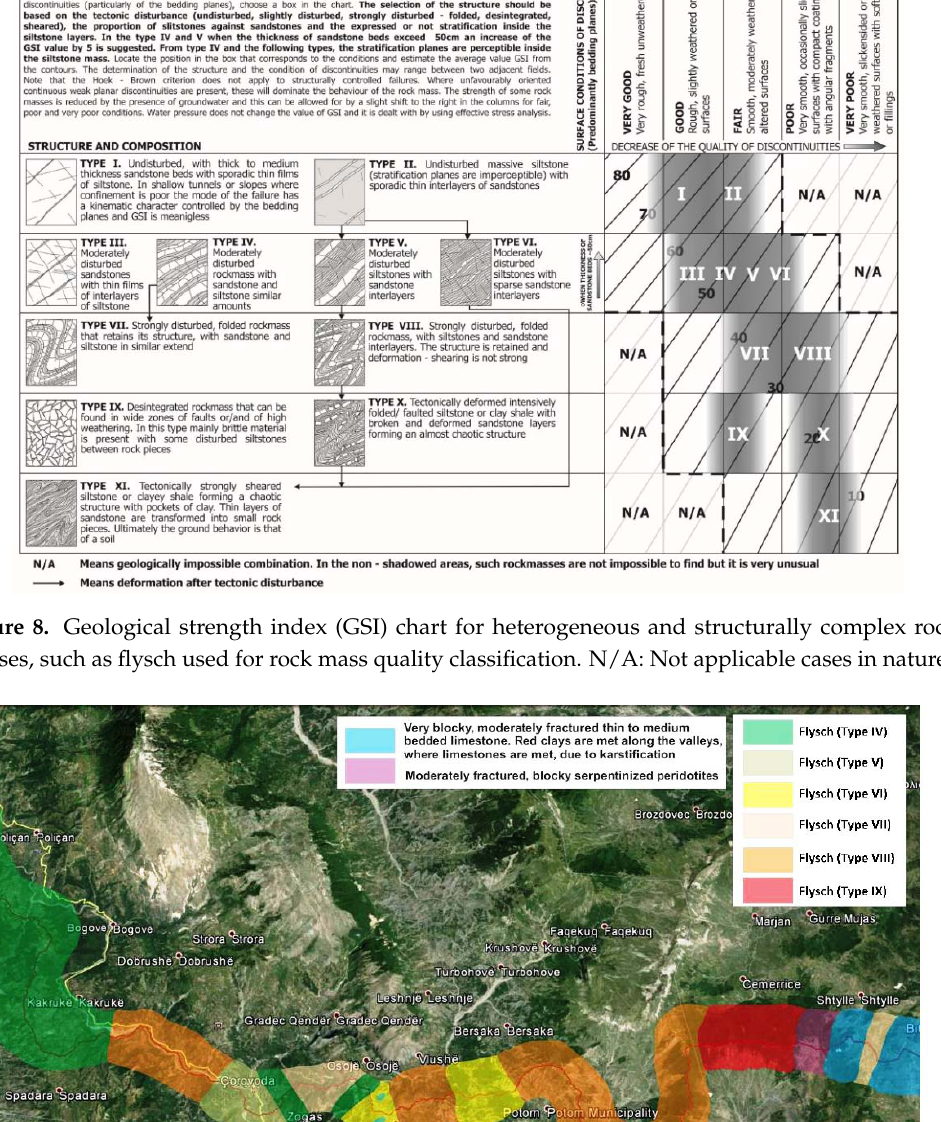
Figure 9. Zonation of the rock mass types and quality along the examined TAP route using the GSI (Figure 8) system for tectonically disturbed heterogeneous rock masses. The areas where most new identified landslides were encountered are characterised by the presence of flysch types VIII (i.e., strongly disturbed siltstones, folded rock mass, with sandstone interlayers) and IX (i.e., tectonically deformed, intensively folded/faulted siltstone with broken and deformed sandstone layers, forming an almost chaotic structure). Limestones (light blue) and ophiolites (peridotites) (purple) were also identified at the eastern edge. The little squares indicate the location of two photos in Figure 10.